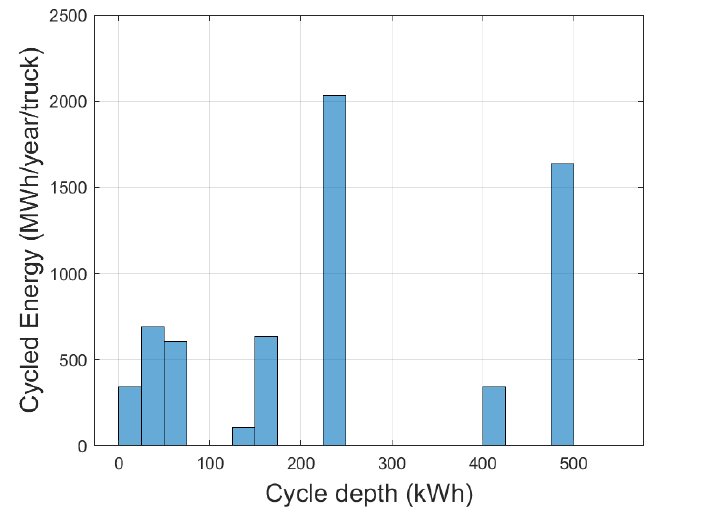
Figure 12. Energy per year cycled in the “Battery + ERS” drivetrain, at different depths of the charge/discharge cycles, for 6500 h/year operation and a mix of drive cycles according to Table 1.